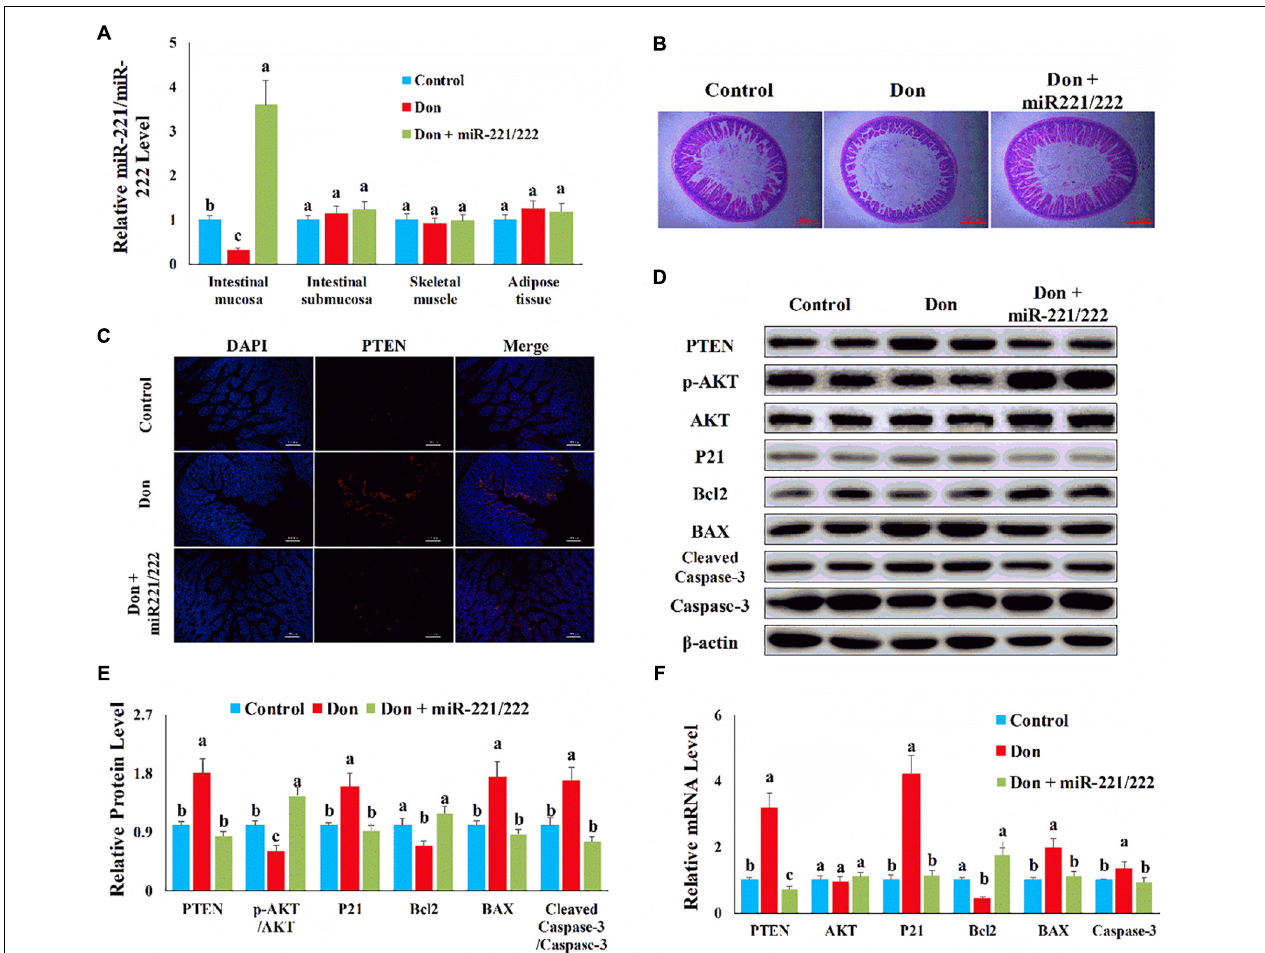
FIGURE 9 | MiR-221/222 attenuated Don-induced intestinal mucosa damage by targeting PTEN. (A) qPCR results indicated that miR-221/222 was specifically overexpressed in intestinal epithelial cells by adenovirus. (B) Morphological observation of small intestinal villi by H&E staining. (C) Representative images of the PTEN immunofluorescent staining for apoptotic intestinal epithelial cells. PTEN: red, the target gene of miR-221/222; DAPI: blue, cell nucleus; Merge: the apoptotic cells. (D) Western blot results showed Don-induced apoptosis in intestinal epithelial cells relied on PTEN. (E) The relative protein levels obtained by WB band gray scanning. (F) qPCR results indicated that miR-221/222 attenuated Don-induced intestinal mucosa damage by targeting PTEN. Our results were presented as mean ± SEM of triplicate independent experiments for each group. Bars with different letters indicate they are significantly different ( p < 0.05). In (B) , magnification = × 40; the scale bar on the photomicrographs represents 500 µ m. In (C) , magnification = × 400; the scale bar on the photomicrographs represents 100 µ m. Don, gavage mice with Don (2.5 mg/kg body weight) and injected adenovirus–CDX2 promoter–miR-221/222 negative control. Don + miR-221/222, gavage mice with Don (2.5 mg/kg body weight) and injected adenovirus–CDX2